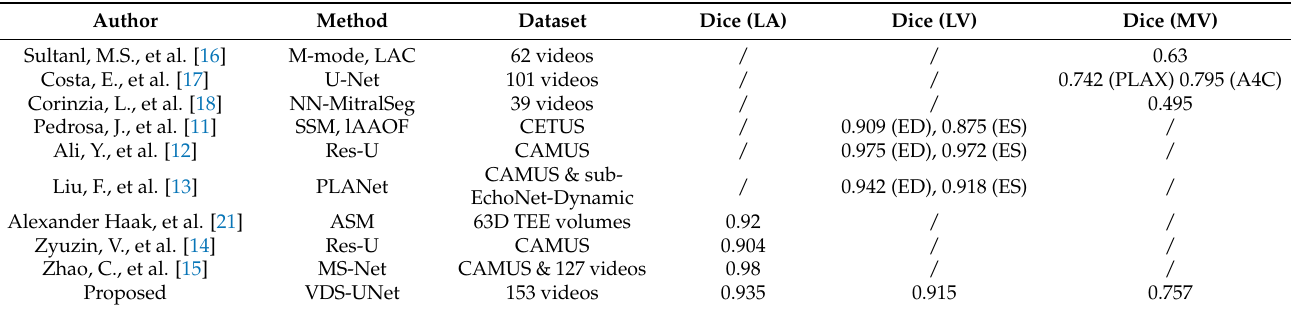
Table 3. Comparison of the segmentation results of this study and other studies.